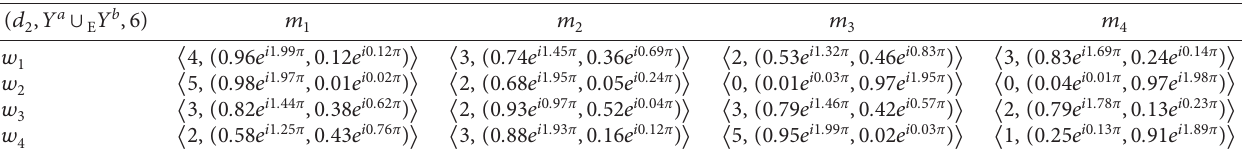
Table 15: Extended